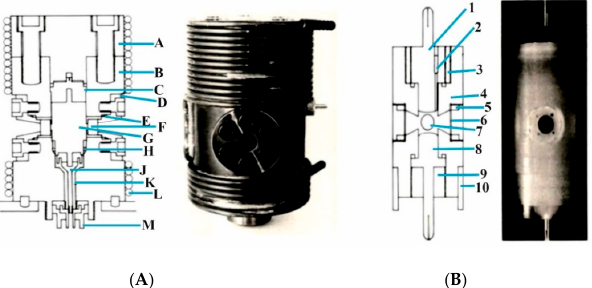
Figure 9. ( A ) High-pressure temperature-jump cell as designed by Doss et al. High-pressure cell: A—vessel lid, B—vessel body, C—steel piston, D—window support, E— ∆ - and O-rings, G—space for T-jump cell, H— ∆ - and O-ring, J—steel high-voltage connector, K—insulation material, L—circulation coil, and M—high-voltage plug. ( B ) T-jump cell: 1—upper electrode, 2—deaeration hole, 3—electrode thread support, 4—Kel-F cell body, 5—membrane support, 6—Teflon membrane, 7—optical window, 8—lower electrode, 9—threaded bolt, and 10—support ring. Reproduced from Reference [25], with the permission of AIP